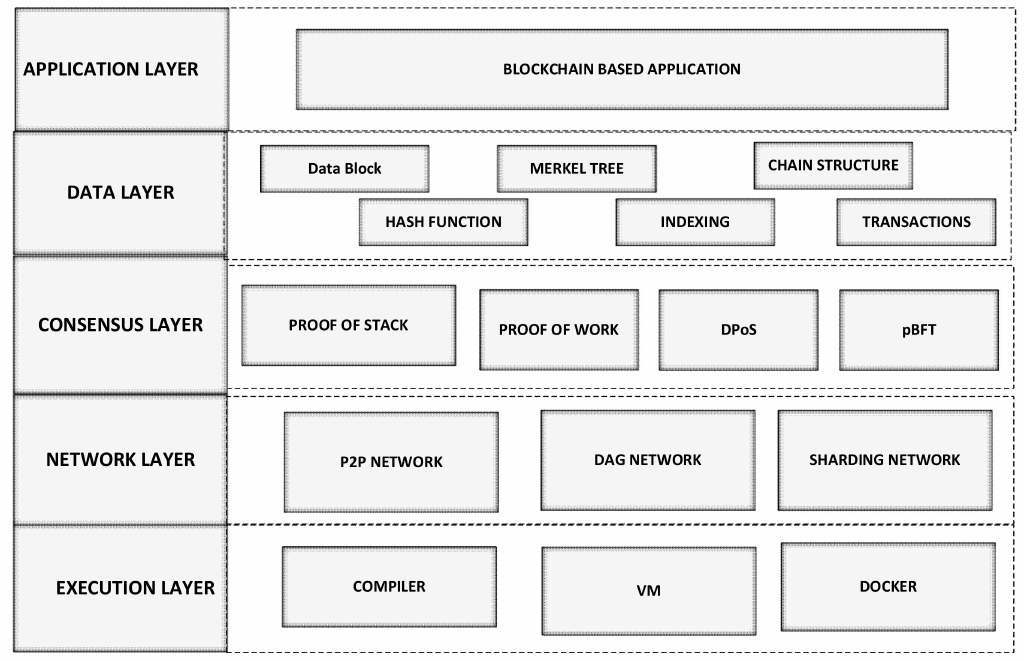
Figure 1. The layered architecture of BC.